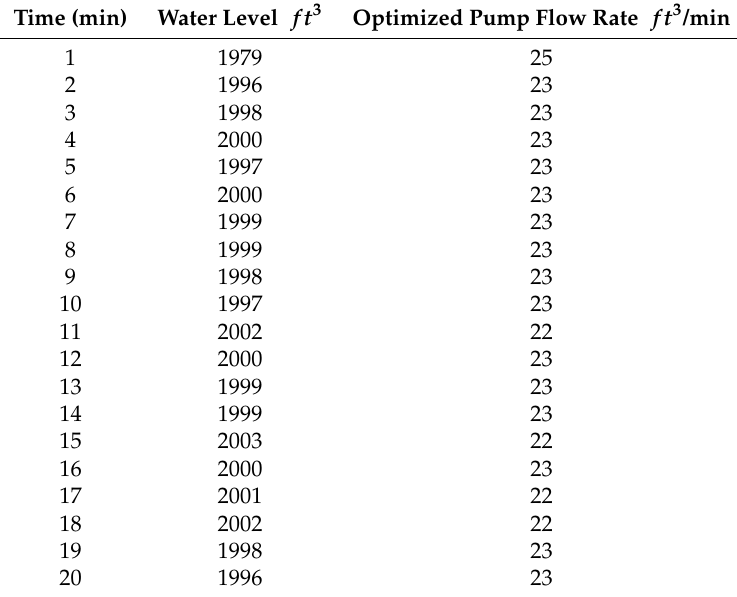
Table 3. Data log of tank water level for first 20